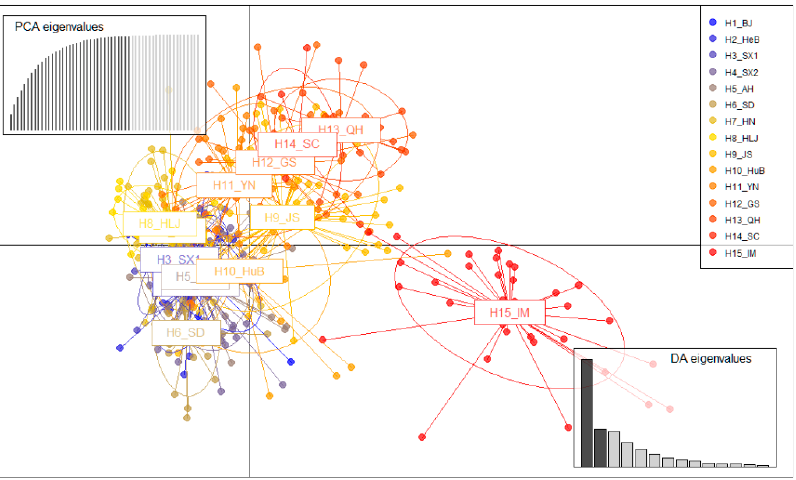
Figure 2. Scatterplot from discriminant analysis of principal components (DAPC) of the first two principal components discriminating Pt populations by regions. Points represent individual observations. Lines and shapes represent population membership.